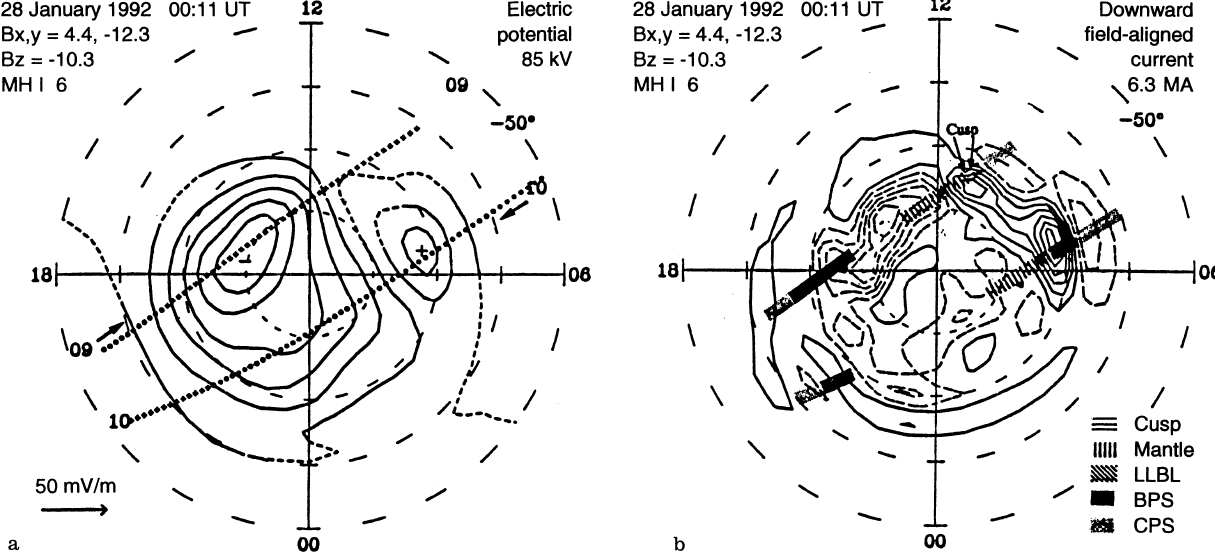
Fig. 3a, b. Patterns of the a ionospheric convection and b field-aligned current derived at 0011 UT on January 28, 1992, in the Southern Hemisphere. The contour interval for the field-aligned current is 0.4 (cid:108) A/m 2 , starting (cid:139)0.2 (cid:108) A/m 2 , from Lu et al